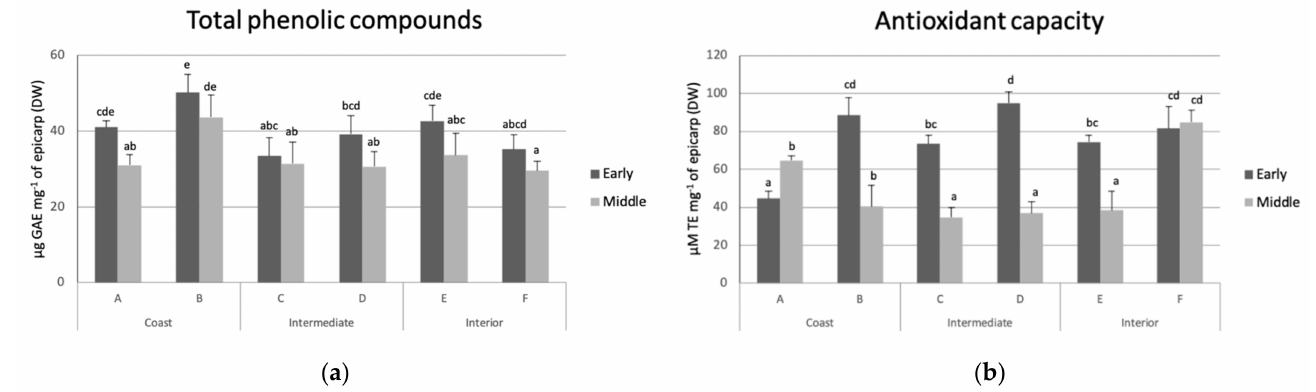
Figure 2. ( a ) Total phenolic compounds (TPC) expressed as gallic acid equivalents (GAE) and ( b ) antioxidant capacity (CA) expressed as trolox equivalents (TE) in avocado fruit from orchards of coast (A and B), intermediate (C and D), and interior (E and F) zones of early and middle harvests. Different lower-case letters in bars show statistical differences among orchards and each harvest time (95%